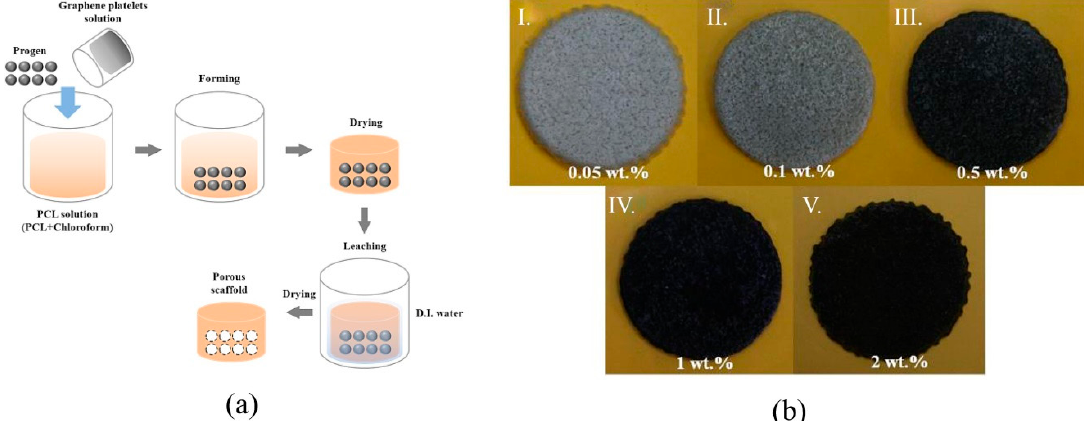
Figure 6. Illustrations of polycaprolactone/graphene platelet scaffolds preparation. Graphene (GR) platelets were prepared using graphite via intercalation at 700 °C for 60 s. The formed GR platelets were dispersed in trichloromethane and mixed together with NaCl (progen) with a polycaprolactone solution (PCL), stirred for 2 h, and poured into a form. After drying, the system was immersed in deionized water (D.I.) to remove NaCl and consequently dried to form a porous scaffold. Various GR amounts were used for the scaffold preparation. ( a ) Scheme of PCL/GR scaffold preparation and ( b ) scaffold samples with various contents of GR platelets I. 0.05 wt%, II. 0.1 wt%, III. 0.5 wt%, IV. 1.0 wt%, and V. 2.0 wt%. Adapted from [141], Elsevier, 2020.